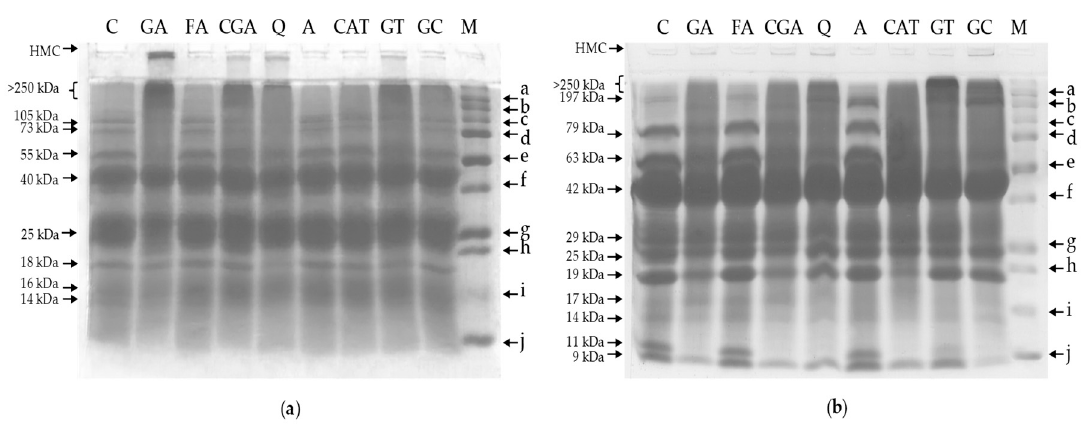
Figure 5. The effect of phenolic compounds on the SDS-PAGE profile of: ( a ) albumins; ( b ) globulins. C–control sample, GA, FA, CGA, Q, A, CAT, GT, GC–protein samples after incubation with gallic acid, ferulic acid, chlorogenic acid, quercetin, apigenin, catechin, green tea, and green coffee extracts, respectively; M–molecular weight markers: a (250 kDa), b (150 kDa), c (100 kDa), d (75 kDa), e (50 kDa), f (37 kDa), g (25 kDa), h (20 kDa), i (15 kDa), j (10 kDa); HMC (high molecular complex).